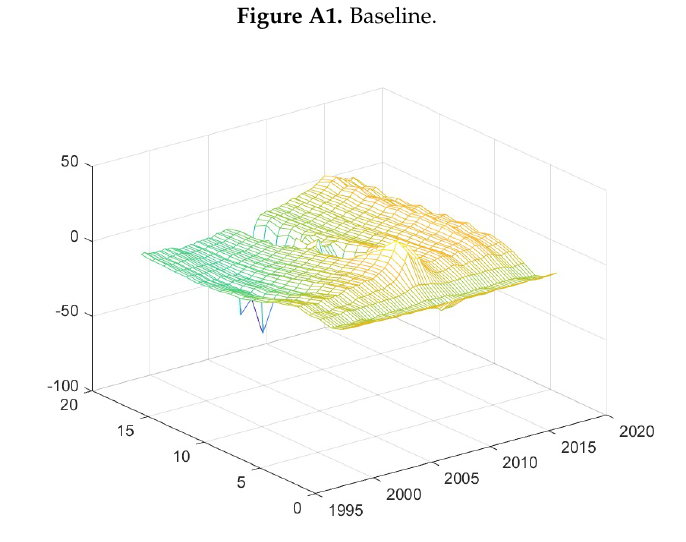
Figure A1. Baseline.